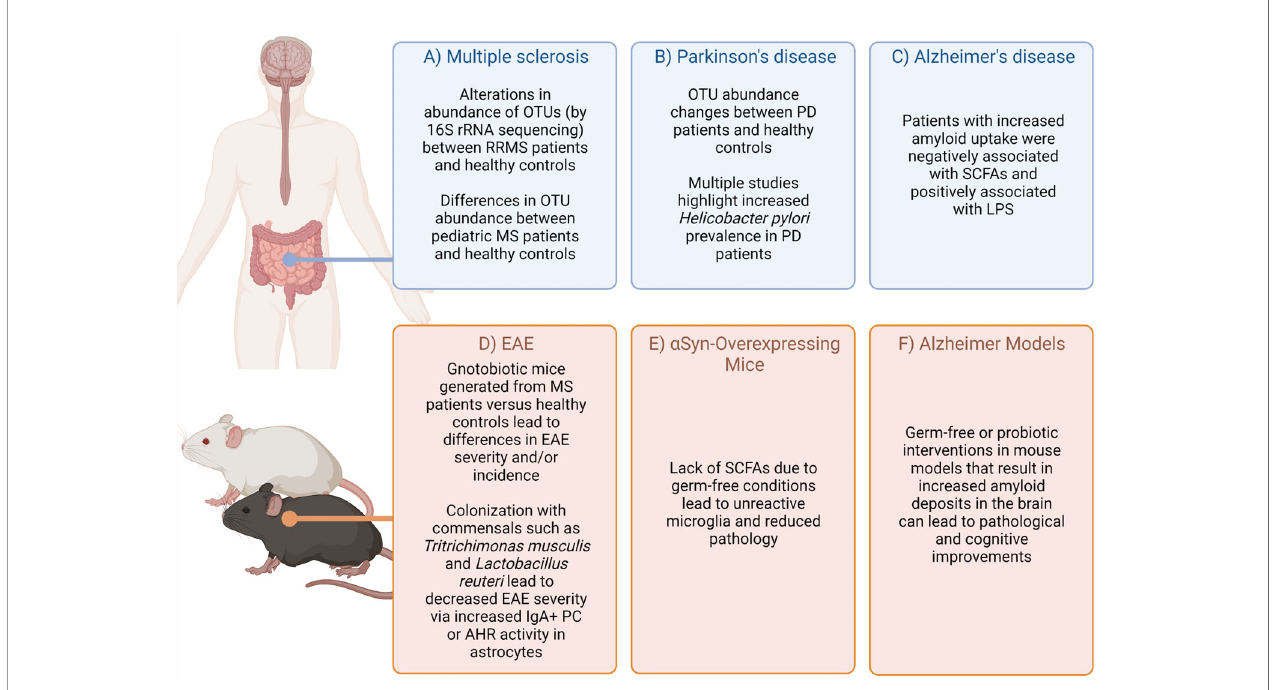
FIGURE 1 | Highlighted evidence for the relationship of microbiota affects in CNS-speci fi c human diseases and animal models. Complex diseases of the CNS are often dif fi cult to query in humans due to scarcity of tissue samples. However, combining evidence from patients, healthy controls (A – C) (1 – 14), as well as animal models (D – F) (15 – 23) can provide some suggestive evidence on how the microbiota may impact disease. Figure made using